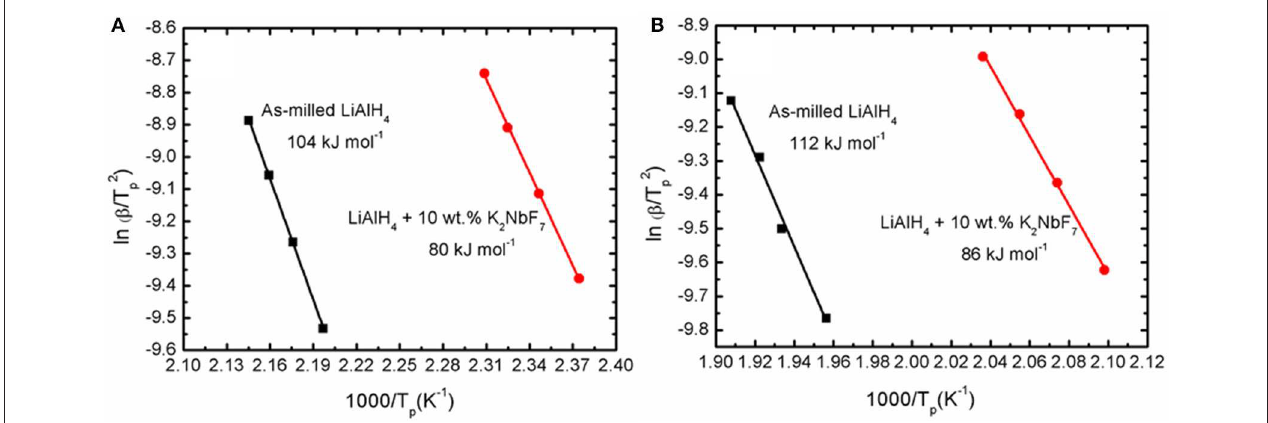
FIGURE 5 | Corresponding Kissinger plots of the as-milled LiAlH 4 and LiAlH 4 + 10 wt.% K 2 NbF 7 for the (A) first stage and (B) second stage of reaction.